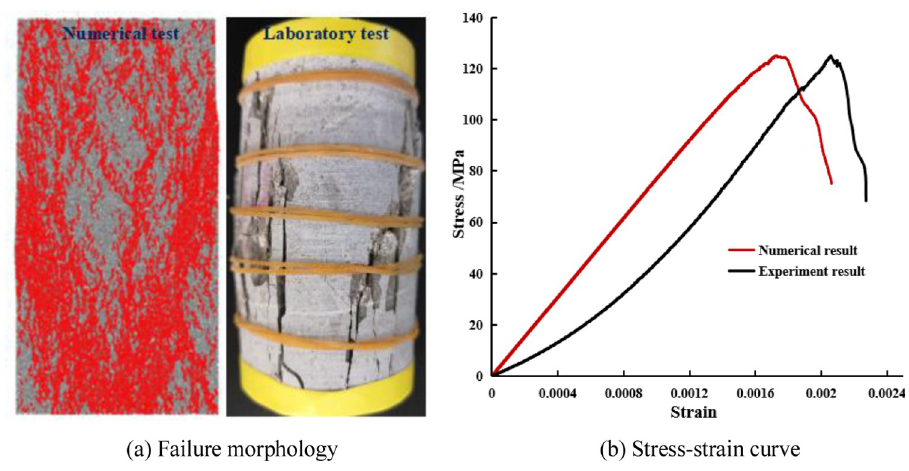
Fig 3. Verification of the experimental and numerical results. (a) Failure morphology, (b) Stress-strain curve.